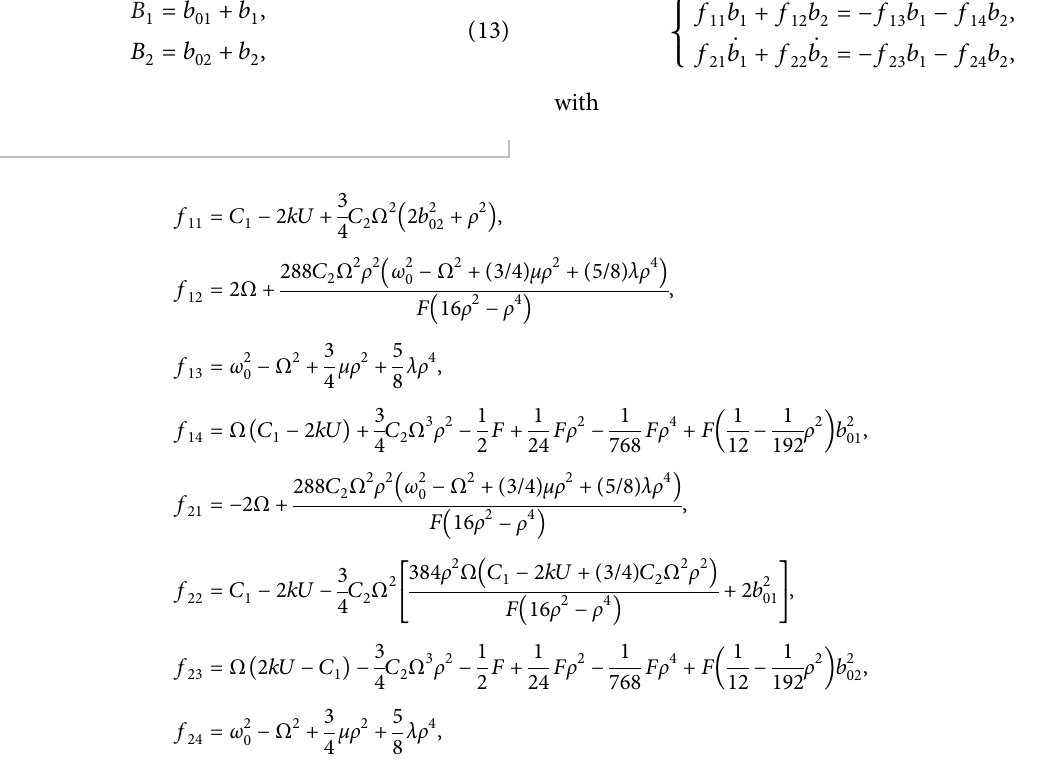
Figure 4: Frequency response curves for ϵ � − 1 with the parameters: ω 0 . 00001. (a) Effect of amplitude F of external excitation, (b) effect of the control parameter U , and (c) effect of control gain parameter K